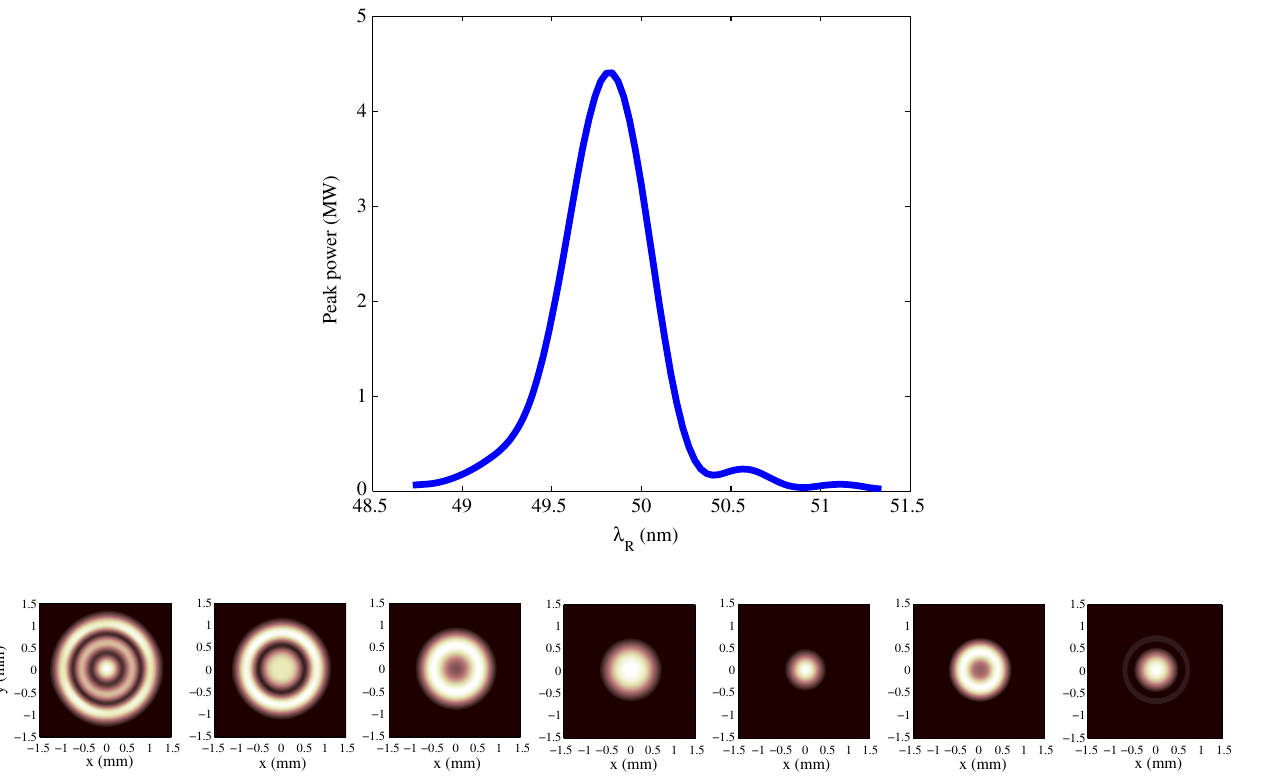
FIG. 3. The peak power (the upper plot) and the spatial profile (the lower plots) of coherent photon beam dependence on the radiator resonant wavelength (i.e., scanning the undulator gap). The radiator resonant wavelength for the lower plots is 48.84, 49.14, 49.49, 49.84, 50.20, 50.47, and 50.70 nm from left to right, respectively.